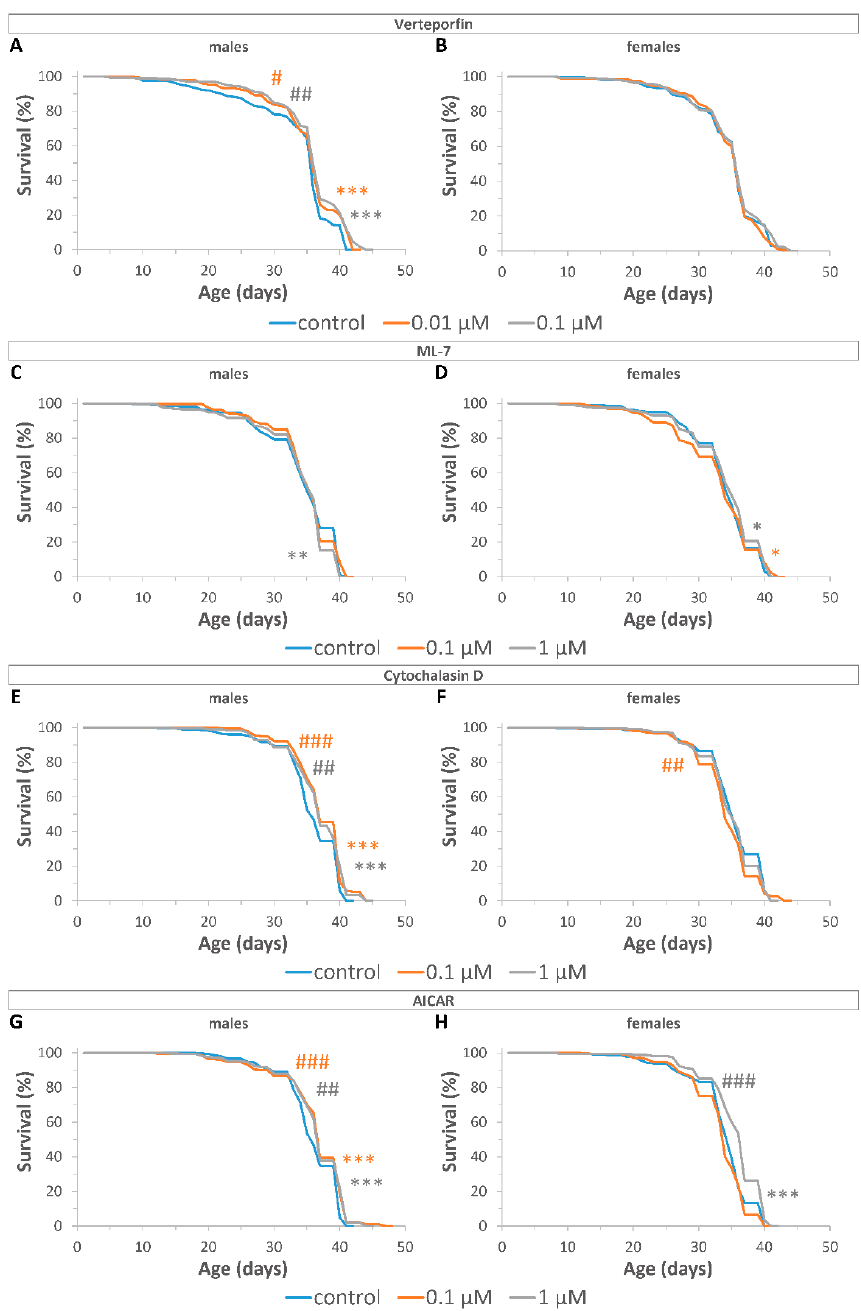
Figure 3. Effects of YAP/TAZ inhibitors on the lifespan of male ( A , C , E , G ) and female ( B , D , F , H ) flies after treatment with VP ( A , B ); ML7 ( C , D ); CD ( E , F ); AI ( G , H ). Fleming–Harrington test sensitive against early ( # p < 0.05, ## p < 0.01, ### p < 0.001) and later (* p < 0.05, ** p < 0.01, *** p < 0.001) differences were used to compare survival curves between inhibitor-treated and control flies. Bonferroni correction was used for multiple comparisons. Two independent experiments were performed: n = 287 (VP control, males); n = 306 (0.01 µ M VP, males); n = 293 (0.1 µ M VP, males); n = 290 (ML control, males); n = 277 (0.1 µ M ML, males); n = 299 (1 µ M ML, males); n = 290 (CD control, males); n = 324 (0.1 µ M CD, males); n = 303 (1 µ M CD, males); n = 293 (AI control, males); n = 321 (0.1 µ M AI, males); n = 293 (1 µ M AI, males); n = 282 (VP control, females); n = 305 (0.01 µ M VP, females); n = 281 (0.1 µ M VP, females); n = 300 (ML control, females); n = 274 (0.1 µ M ML, females); n = 283 (1 µ M ML, females); n = 292 (CD control, females); n = 293 (0.1 µ M CD, females); n = 330 (1 µ M CD, females); n = 323 (AI control, females); n = 310 (0.1 µ M AI, females); n = 330 (1 µ M AI,